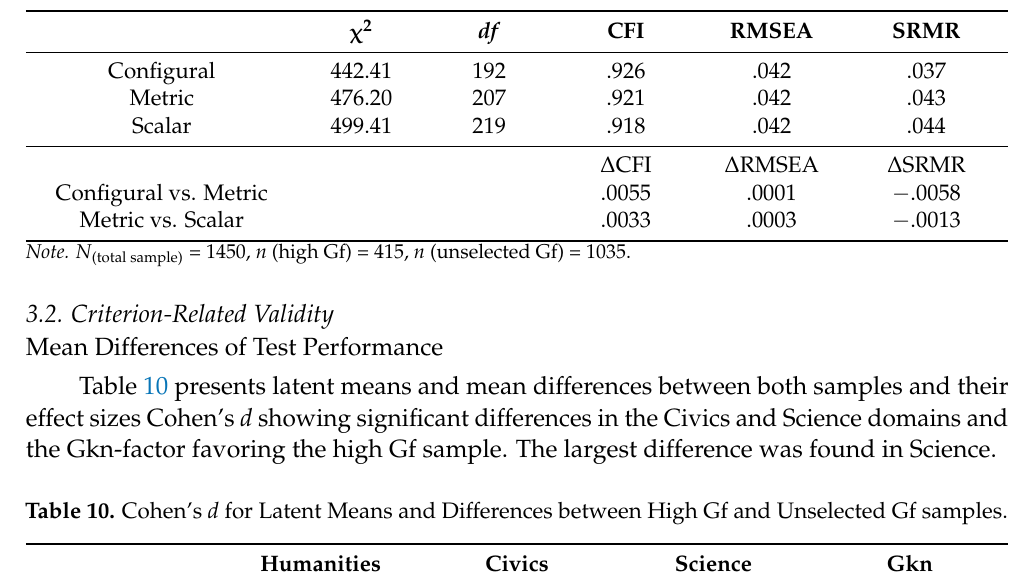
Table 9. Measurement Invariance of Gkn Test between High Gf and Unselected Gf